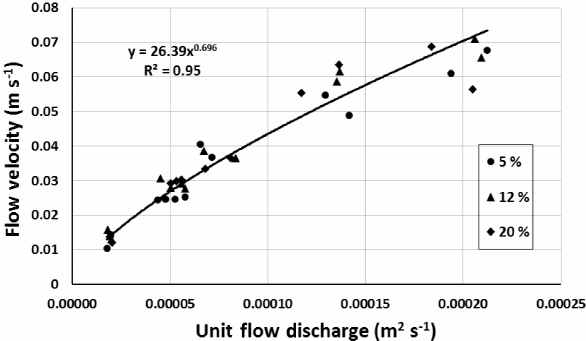
Figure 7. Final flow velocities for all six experiments at each of the three velocity transect measurement transects and two rainfall